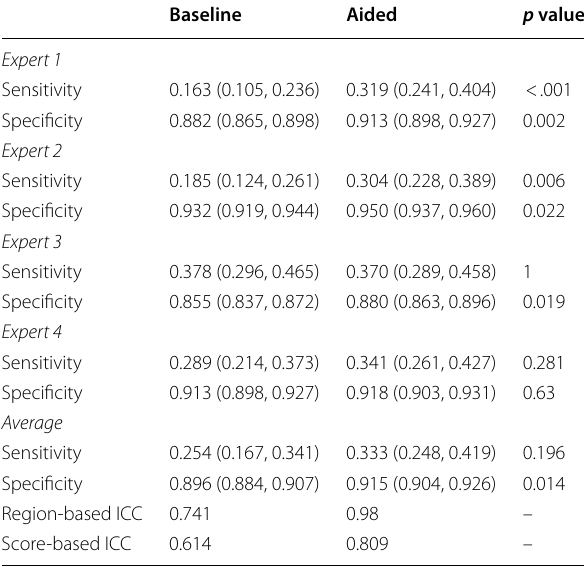
Sensitivity and specificity were expressed as point estimate with lower and upper bound of 95% confidence interval (CI) in parentheses. CI for average sensitivity and specificity was calculated by the Jackknife method Table 3 Average time per case in reading experiment